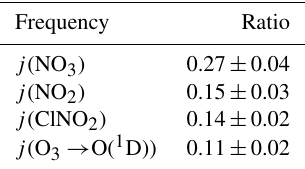
Table 2. Ratios of up- to down-welling photolysis frequencies.